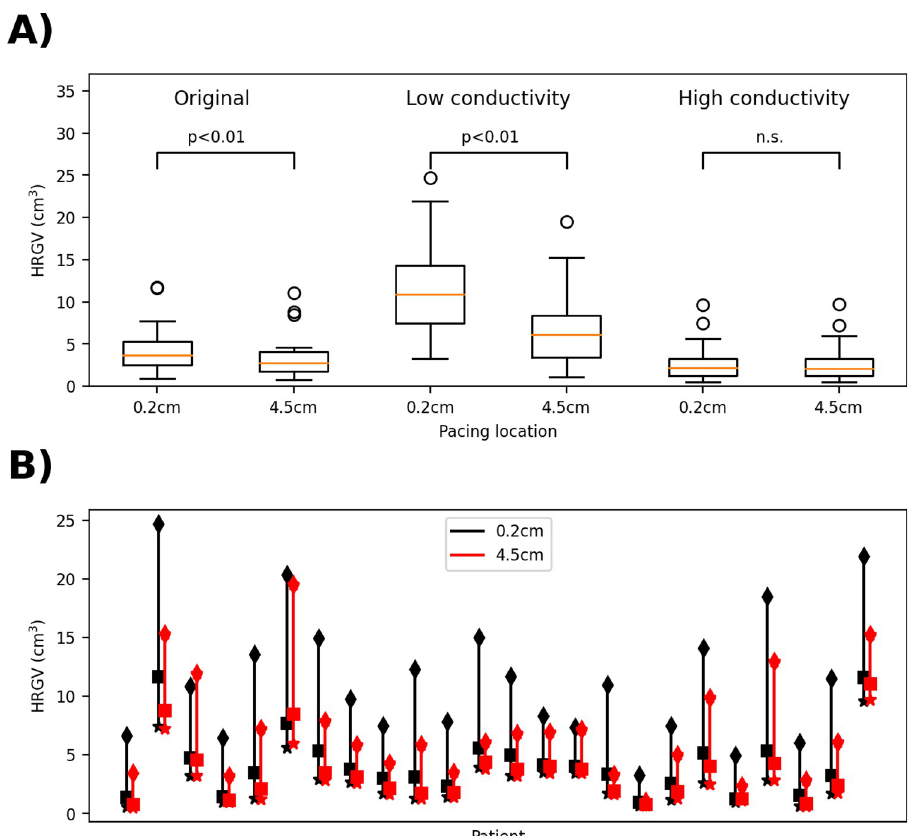
Fig 7. Impact of uncertainty in tissue conductivity on high repolarization gradient volumes (HRGV). A): boxplots comparing pacing at 0.2cm from scar with pacing 4.5cm from scar for each case. B): Range of HRGV values across each of the three cases (low (diamonds), baseline (squares), high conductivity (stars)) for each patient.